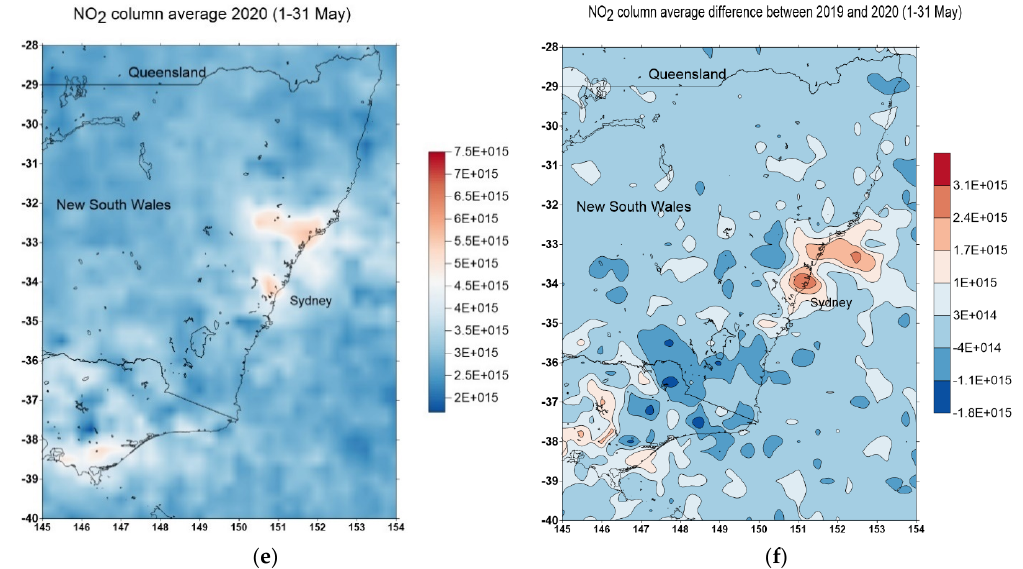
Figure 4. Time averaged map of NO 2 tropospheric column (30% cloud screened) daily 0.25° [OMI OMNO2d v003] 1/cm 2 in April 2019 ( a ), April 2020 ( b ), and the difference in April 2019 and 2010 ( c ). Similarly ( d – f ) are for May 2019 and 2020. The unit is in molecules/cm 2 (data source: NASA Giovanni online https://giovanni.gsfc.nasa.gov/. Accessed on 27 March 2021).